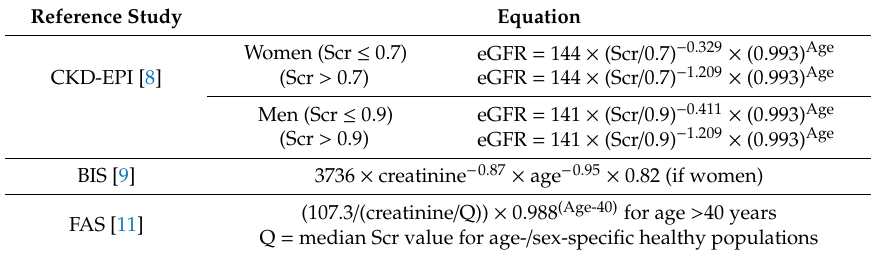
Table 1. Estimated glomerular filtration rate equations used in the present